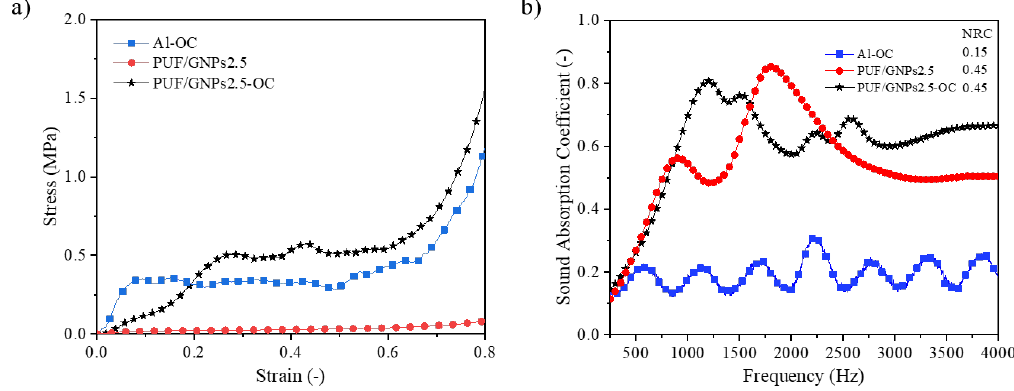
Figure 6. ( a ) Average stress–strain compressive curves; ( b ) sound absorption of Al-OC, PUF/GNPs2.5 and PUF/GNPs2.5-OC.